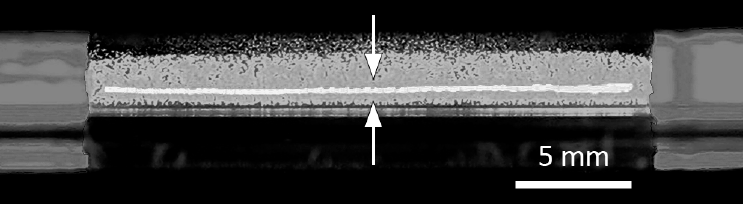
Figure 5. Line-shaped molten zone in a CVD-grown pre-ribbon. The arrows point to the molten zone center.